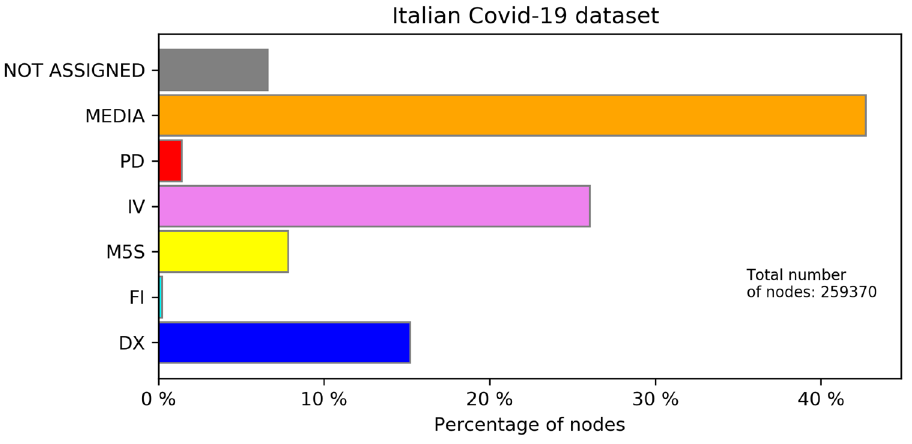
Figure 2. Percentages of nodes in each discursive community, Italian COVID-19 dataset. Due to the presence of politicians and political parties from a specific political area, the various discursive communities are called following their political alignment. “PD” stays for the Italian Democratic Party ( Partito Democratico ); Italia Viva (“IV”) is the political party of the former prime Minister and former PD secretary Matteo Renzi, while M5S is the “Movimento 5 Stelle”, a political movement born on the web and being the most represented party in the Italian parliament at the time of the data collection. “FI” stays for Forza Italia , the political party of the former Prime Minister Silvio Berlusconi, while the “DX” ( Destra ) community includes right wing parties as Lega and Fratelli d’Italia. The most crowded discursive community is the one of Media in which there are most of the online news outcasts and newspapers. The accounts for which it was not possible to assign a discursive community are in